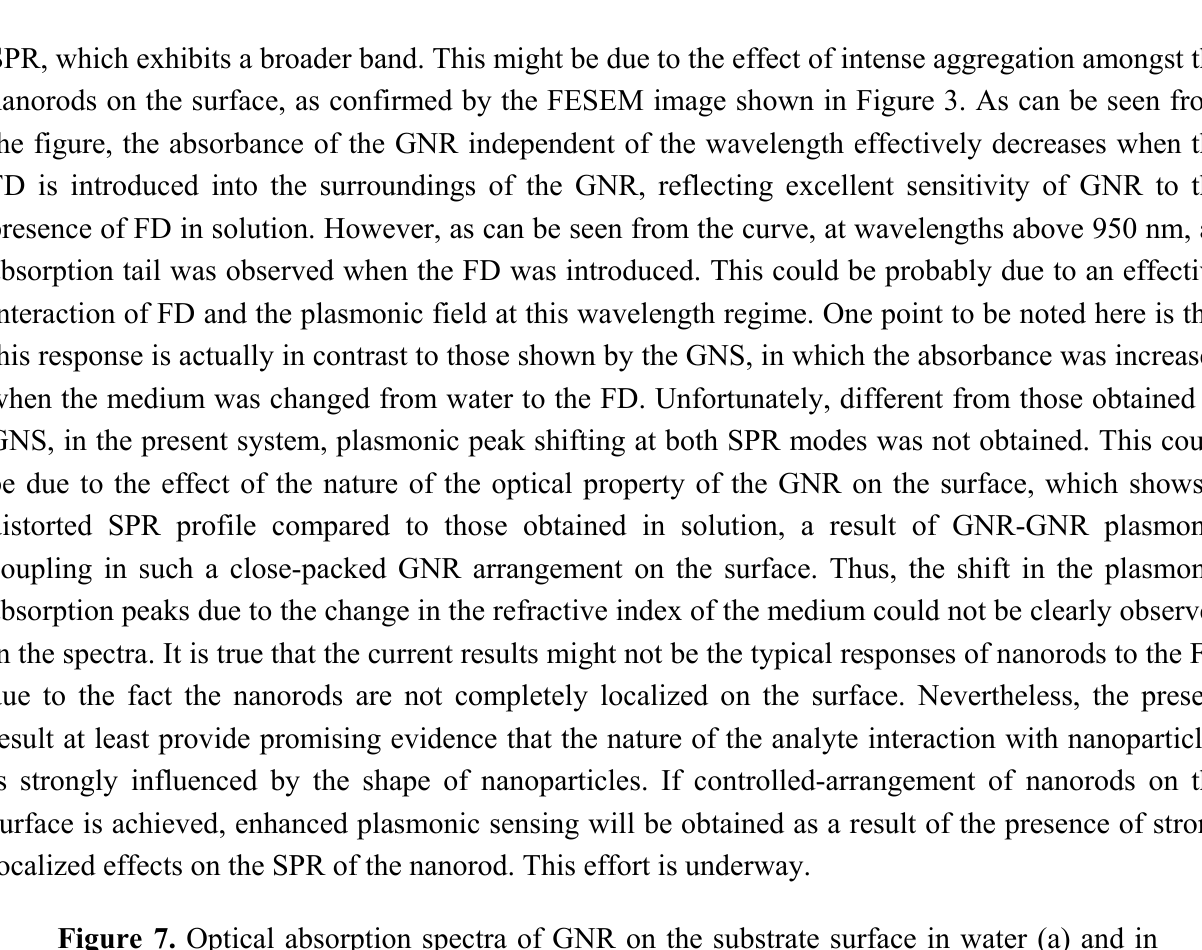
Figure 7. Optical absorption spectra of GNR on the substrate surface in water (a) and in the presence of 10% formaldehyde in water